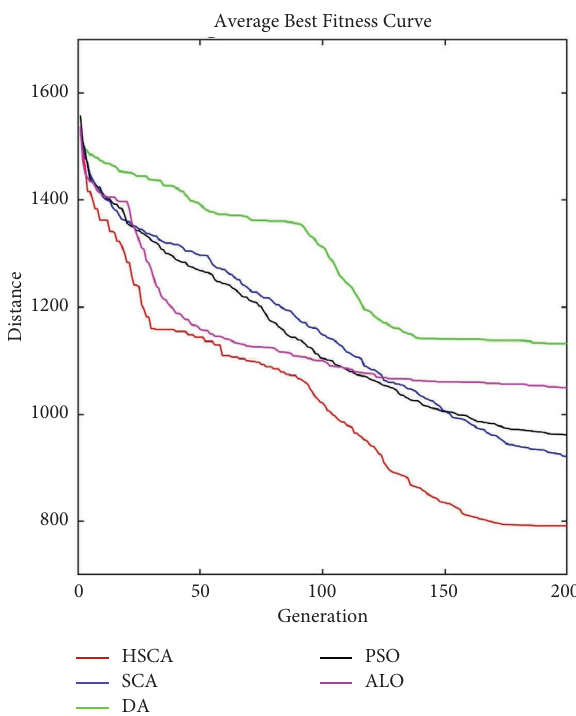
Figure 11: Optimal average values were obtained with diferent algorithms after 20 runs in case study